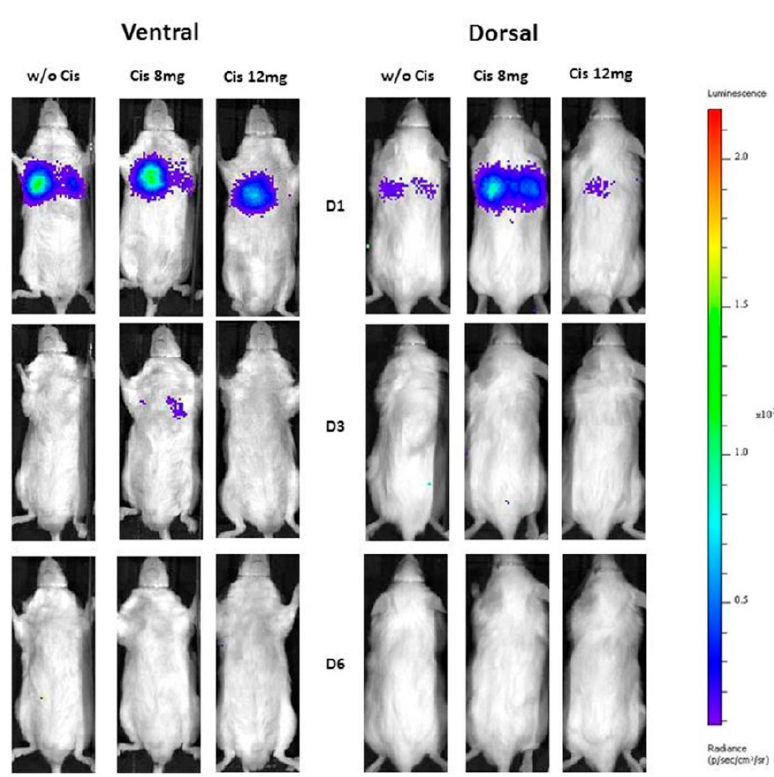
Figure 4. Bioluminescence imaging. Bioluminescence imaging measurements were performed on day 1, 3, and 6 to assess this biodistribution of transplanted Luc + -mASCs. Mice were imaged dorsally and ventrally. Representative animals of each group are shown (controls (w/o Cis) n = 8, Cis 8 mg, n = 10; Cis 12 mg, n = 6).